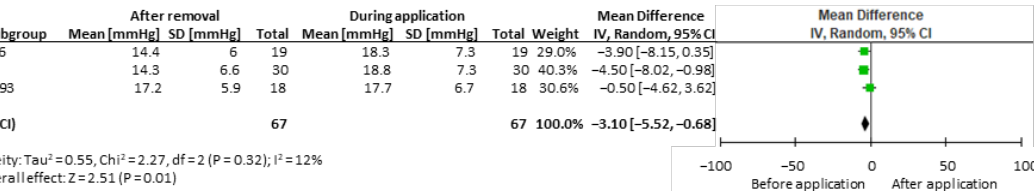
Figure 3. Forest plot of ICP changes after removal of cervical collars in TBI patients identified by the systematic search.